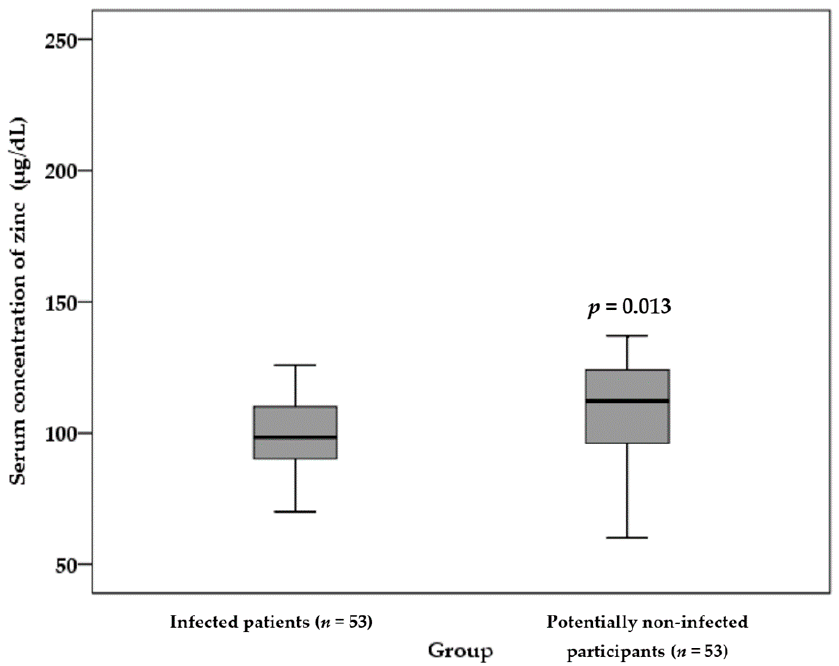
Figure 3. The comparison of the serum concentration of zinc between infected patients and potentially non-infected participants. An independent sample t -test was applied to analyze data. The serum concentration of zinc was significantly lower among infected patients than potentially non-infected participants.